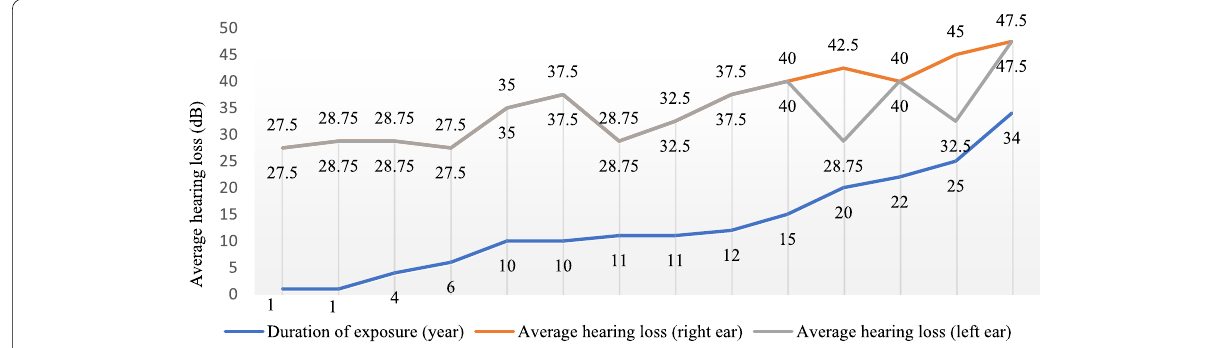
Fig. 3 Distribution of average hearing loss in both ears according to duration of exposure to noise